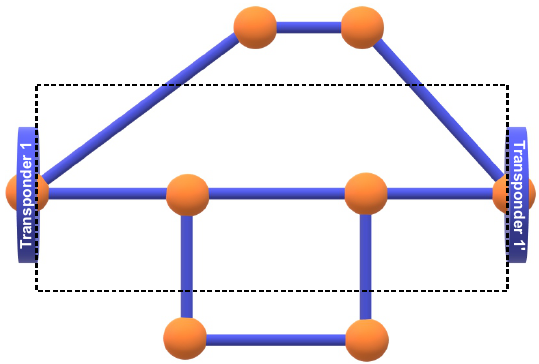
Figure 2. An example of optical network topology.